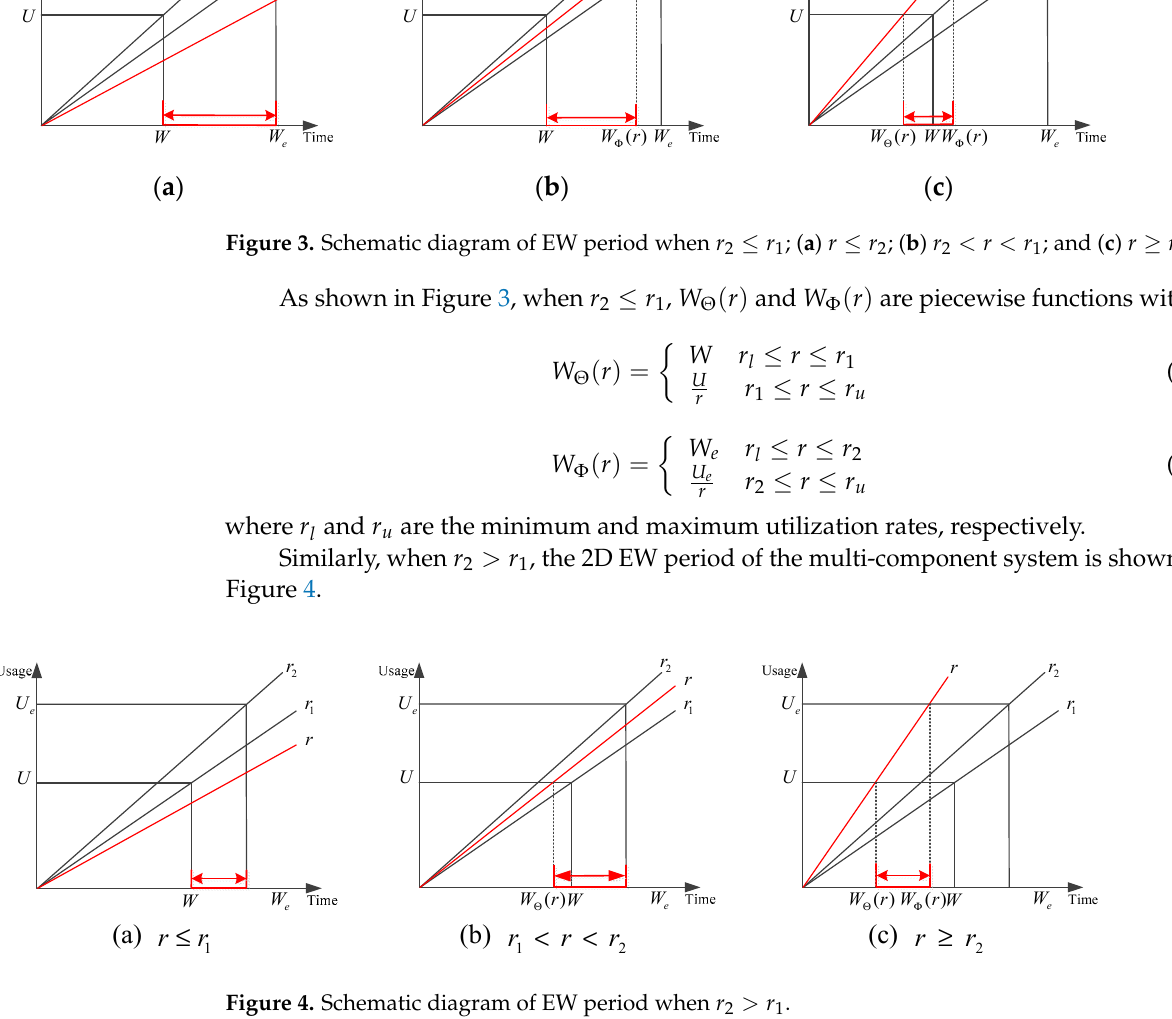
Figure 4. Schematic diagram of EW period when